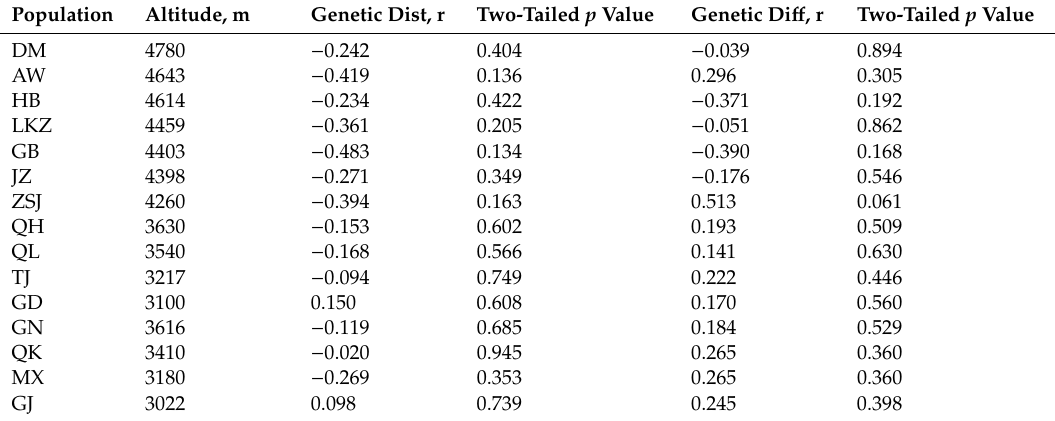
Figure 2. The Genetic distance and absolute difference between altitudes for the population of Zashijia Tibetan sheep (ZSJ). The red triangle, blue square and green rhombus indicate that the respective samples originated from Gansu, Qinghai and Tibet province. Table 2. The altitude and Pearson correlation coefficients between absolute differences in altitude and each population.